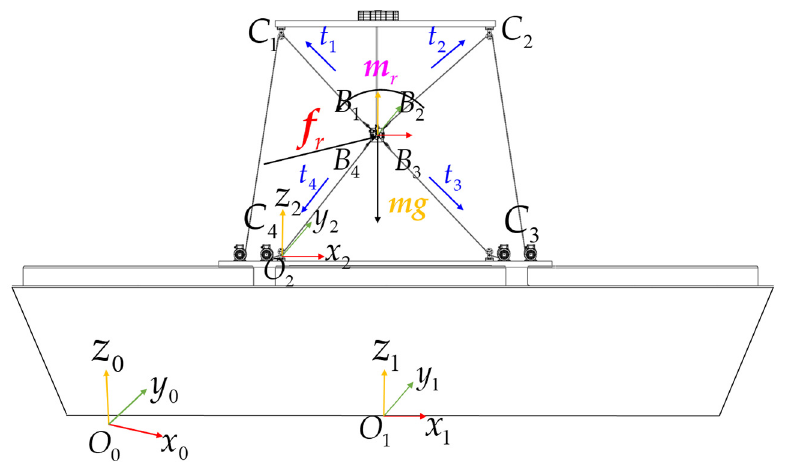
Figure 3. Dynamic parameters of C ‐ DCR.